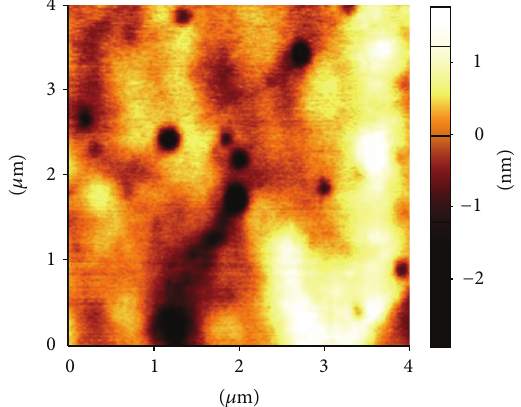
Figure 3: AFM image of the InGaN/GaN LED surface. The V-pits with average depth of 2.5 nm and density of about 9 × 10 7 cm −2 are observed on the surface of the